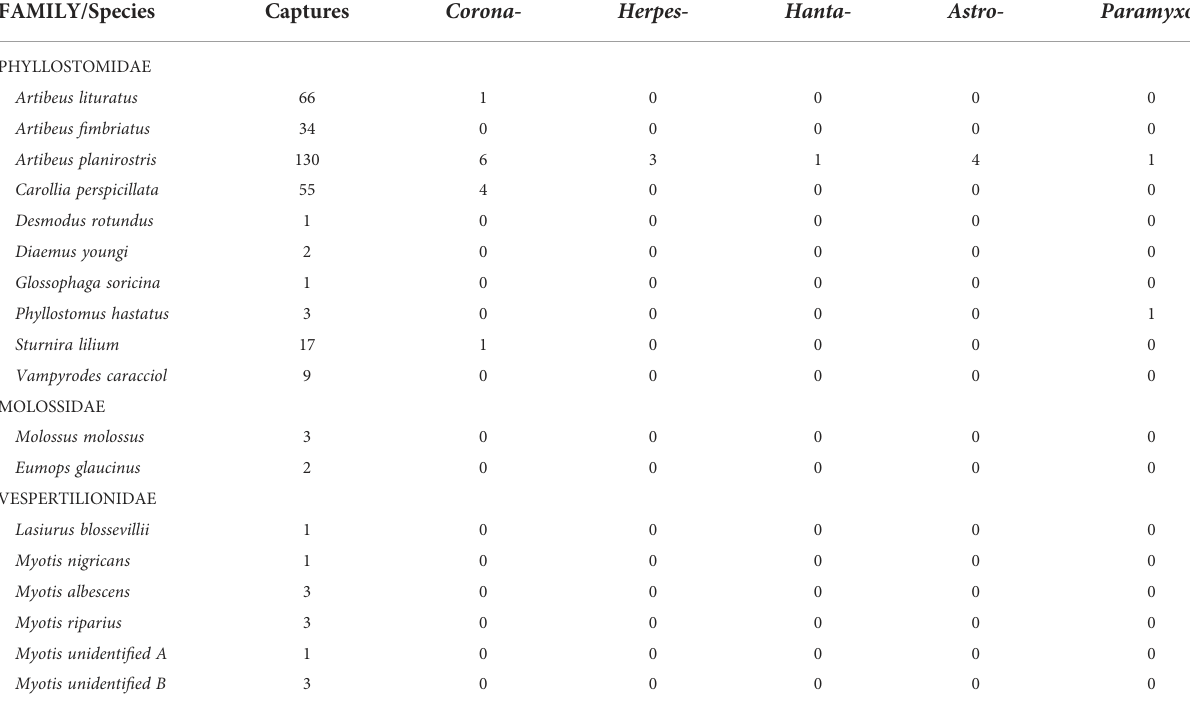
TABLE 2 Total captures of bat species and total viral detections in forested and deforested habitat in the Interior Atlantic Forest.